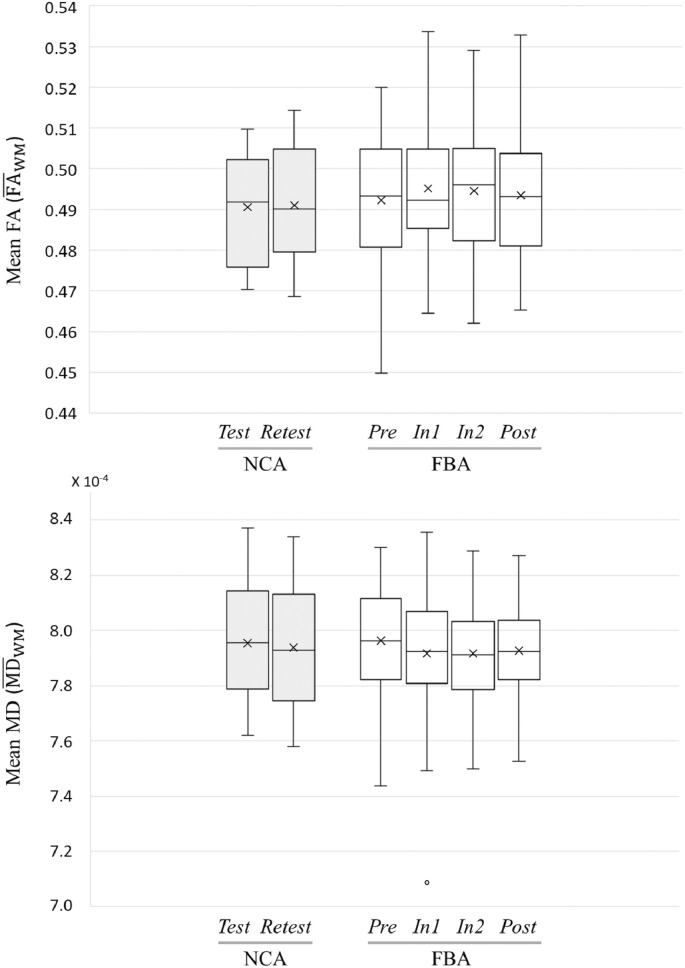
Box-and-whisker plots of distributions of (top) mean FA and (bottom) mean MD over the white matter skeleton (ROIWM) as a function of session for FBA (N = 61) and NCA (N = 15). The horizontal line in each box indicates the median and × indicates the mean. Note that the single outlier subject-session observed for mean MD in FBA at follow-up session In1 was excluded from subsequent ANOVA-based tests.